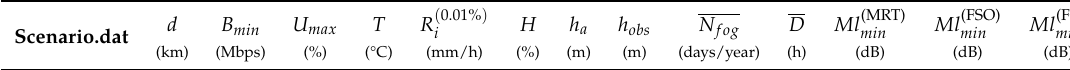
Table 3. Required inputs for the “Scenario.dat”